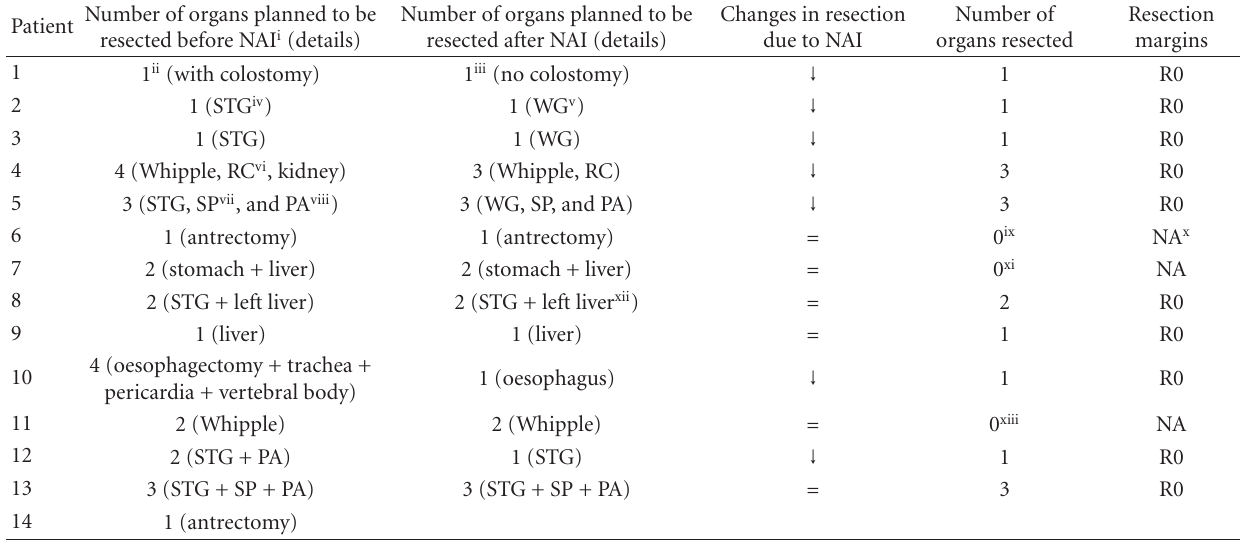
Table 3: Surgical strategy before and after neoadjuvant imatinib, resection performed, and resection margins. Number of organs planned to be Patient resected before NAI i